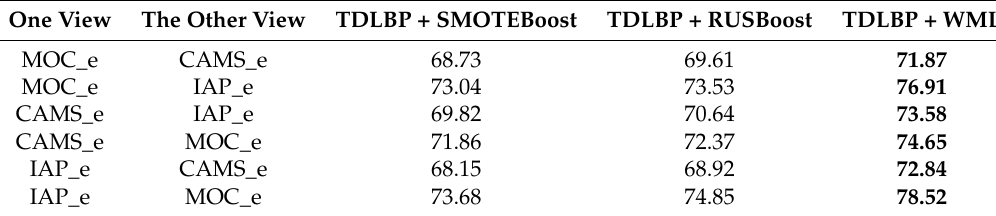
Table 6. Multi-view cloud recognition accuracies (%) comparing the proposed TDLBP + WML with TDLBP + SMOTEBoost and TDLBP +